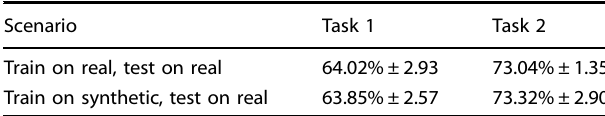
Table 3. Classi fi cation accuracy of the two experimental scenarios in two separate downstream analytics